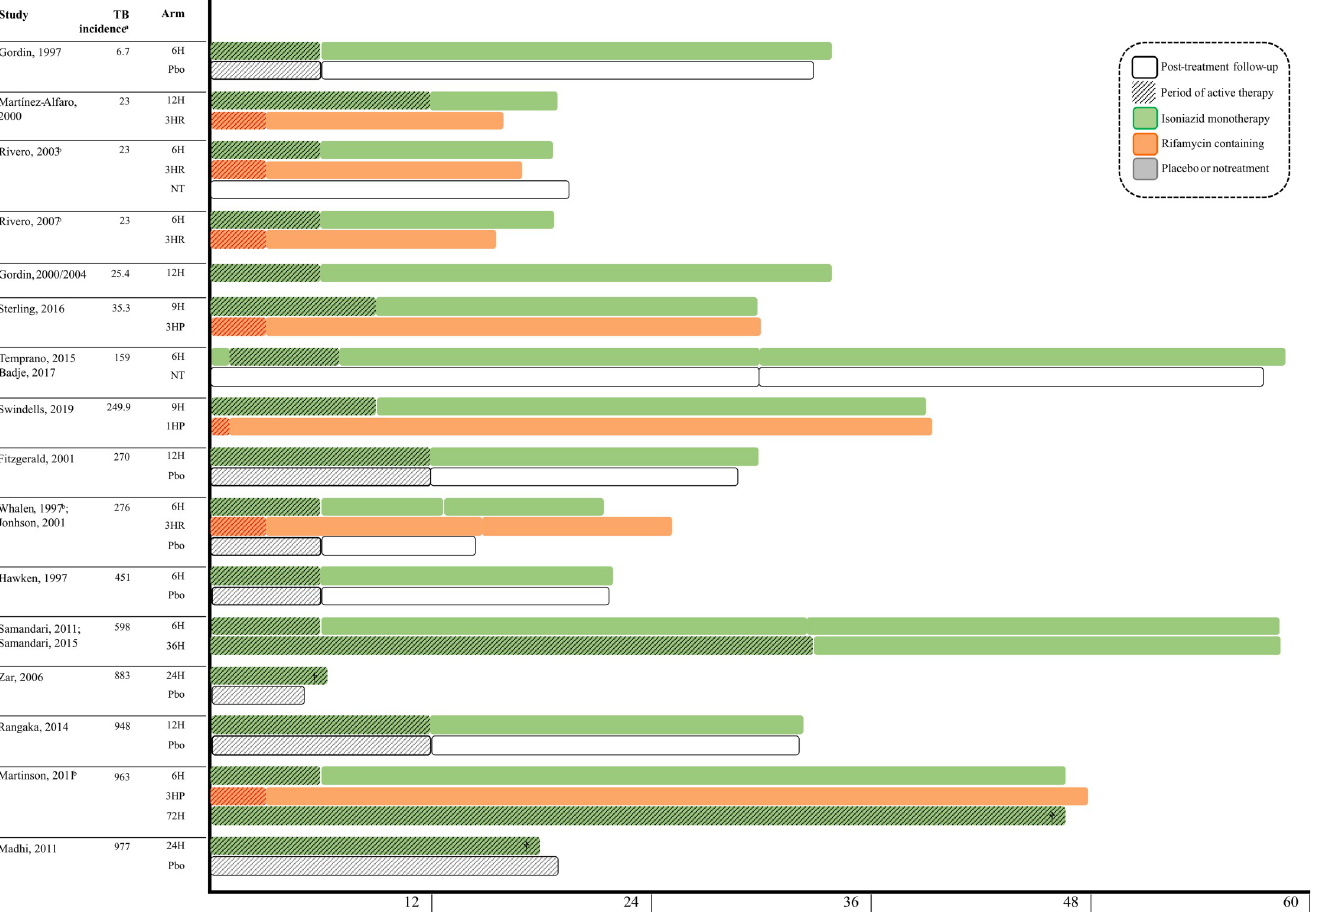
Fig 2. Duration of treatment and posttreatment follow-up of the included studies. Notes: Study arms are abbreviated by the number of months and treatment regimens (H, isoniazid; P, rifapentine; Pbo, placebo; R, rifampin; NT, no treatment). ª WHO TB burden estimates for all forms of TB (cases/100,000 people, year). b Treatment arms considered not of interest were excluded in this figure for simplicity. † Mean or median follow-up of the planned continuous isoniazid regime. TB, tuberculosis; WHO, World Health Organization.